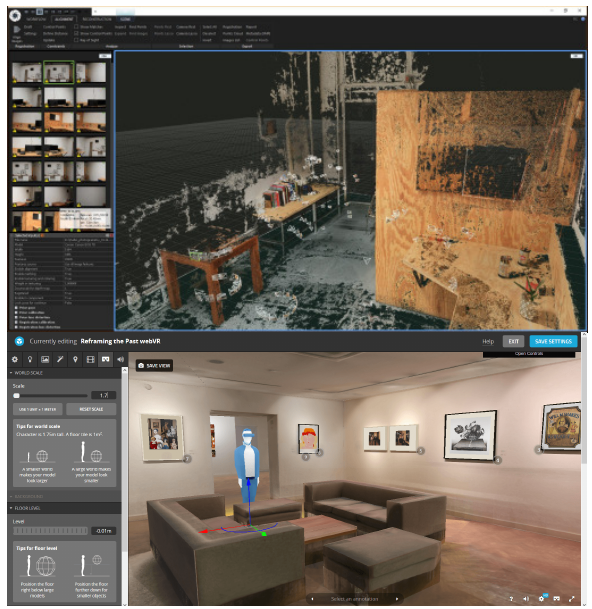
Figure 3. Application of 3d photogrammetry by Reality Capture software and Sketchfab 3d multimedia sharing platform. Images from